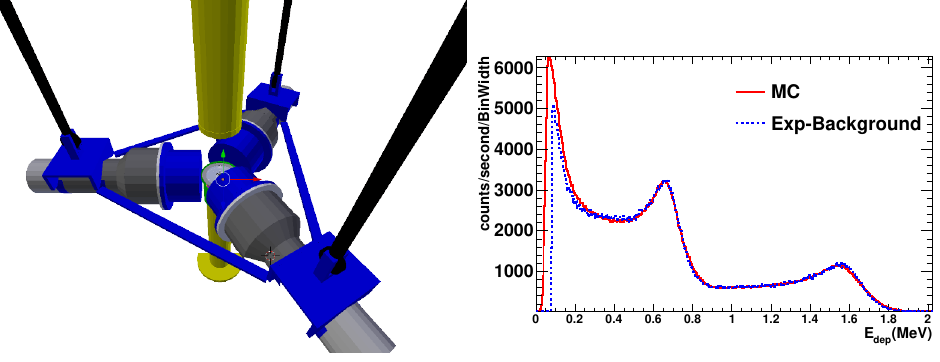
Figure 1. Geometry of the EAR-2 setup as implemented in Geant4 (left). Comparison between simu- lated (MC) and experimental response function to an 88 Y source